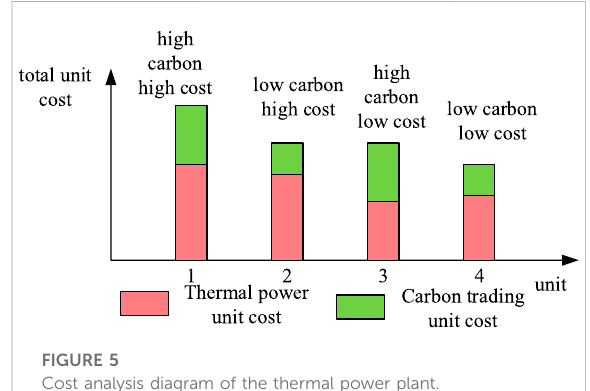
FIGURE 5 Cost analysis diagram of the thermal power plant.